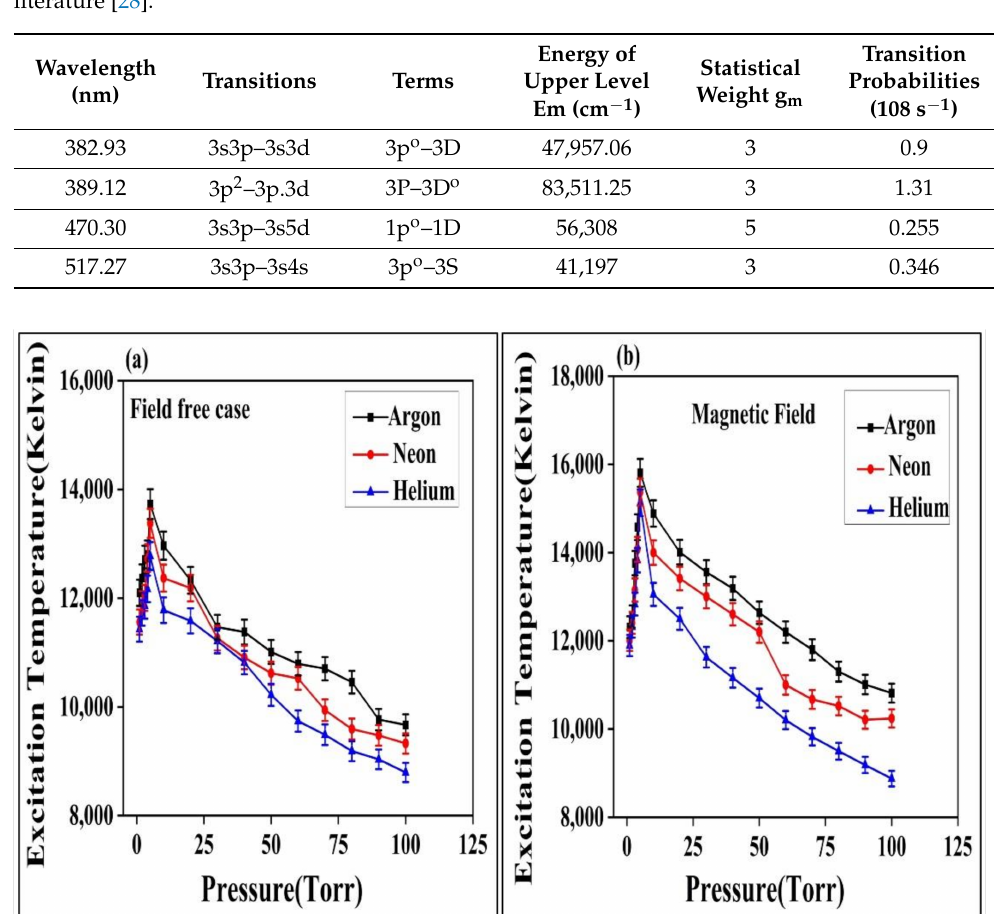
Figure 4. The variation in excitation temperature of laser-induced Mg alloy plasma at various pressures of Ar, Ne, and He environments at ns laser irradiance of 2 GW/cm 2 in the absence ( a ) and presence ( b ) of